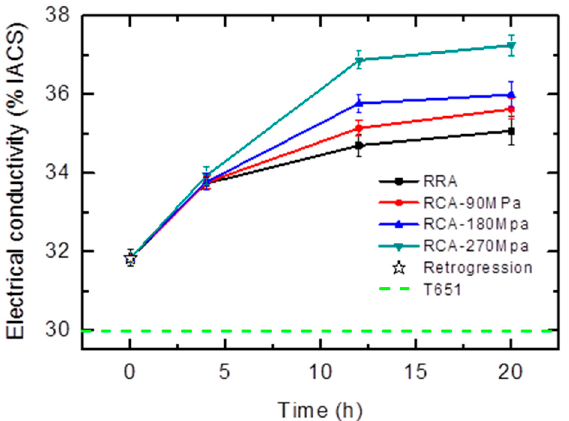
Figure 8. Electrical conductivity of the studied alloy during various aging treatments at 140 ◦